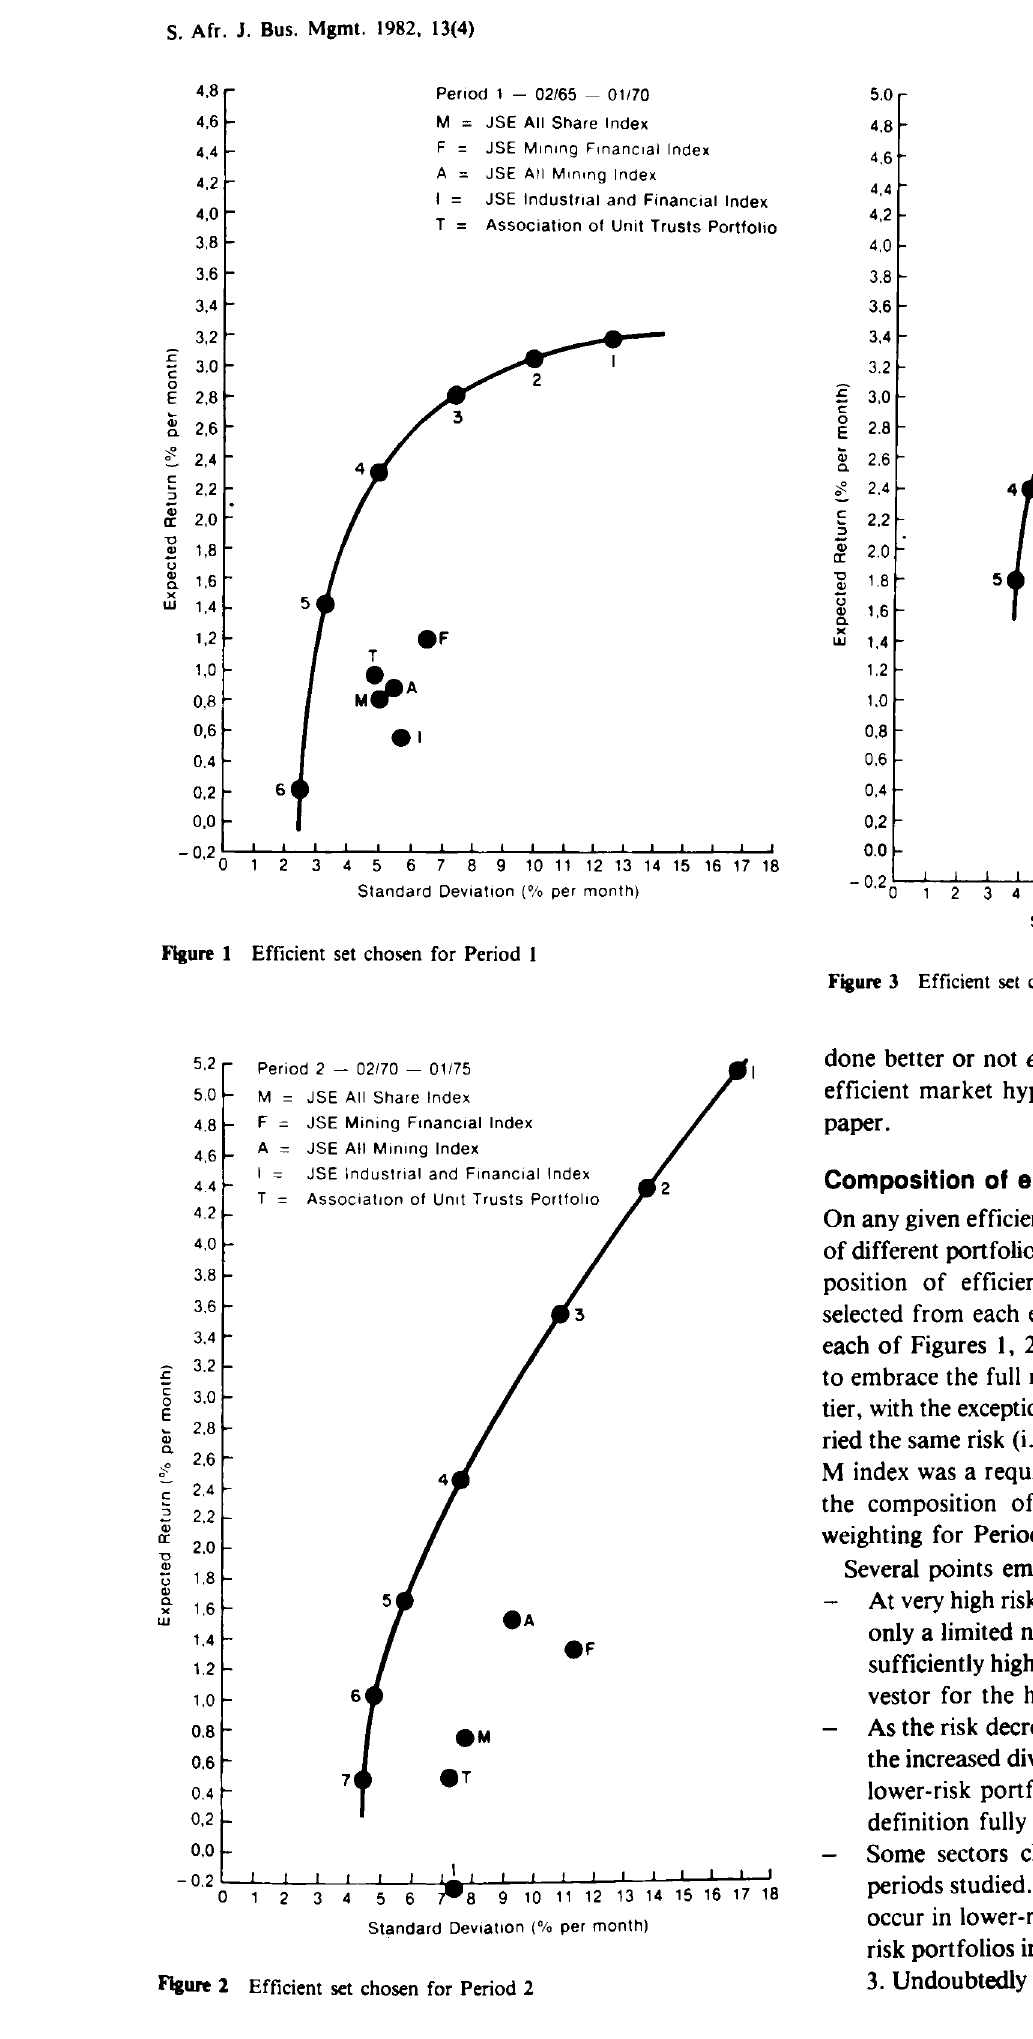
Figure 2 Efficient set chosen for Period 2